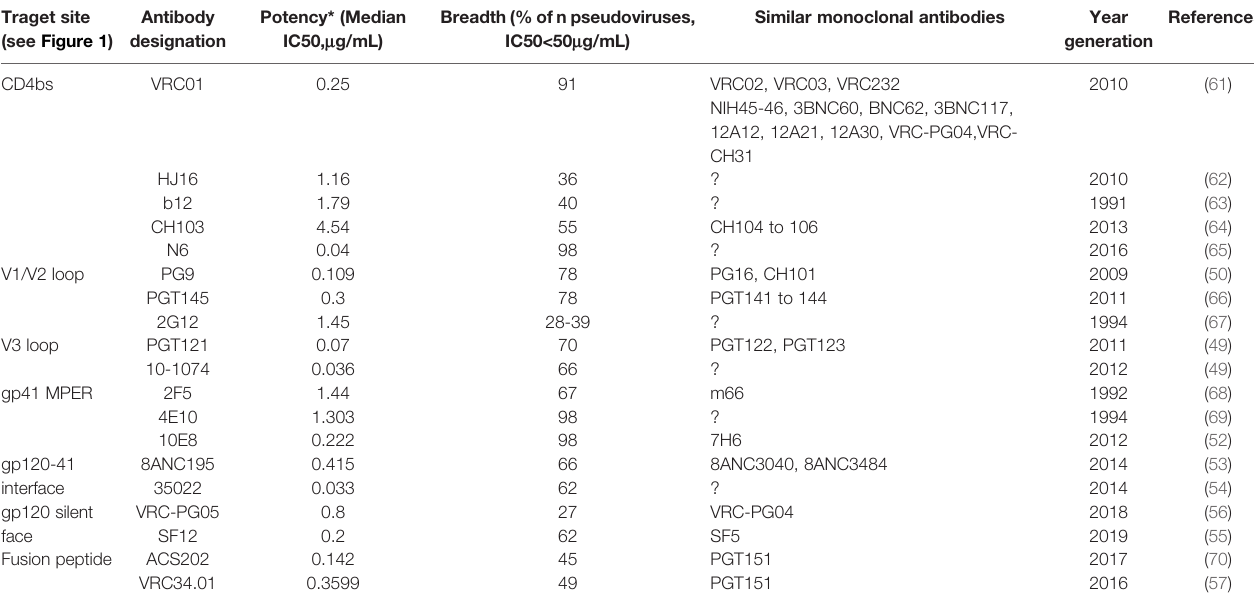
TABLE 1 | Categories, ef fi cacies, and research development of broadly neutralizing HIV-1 antibodies. Traget site (see Figure